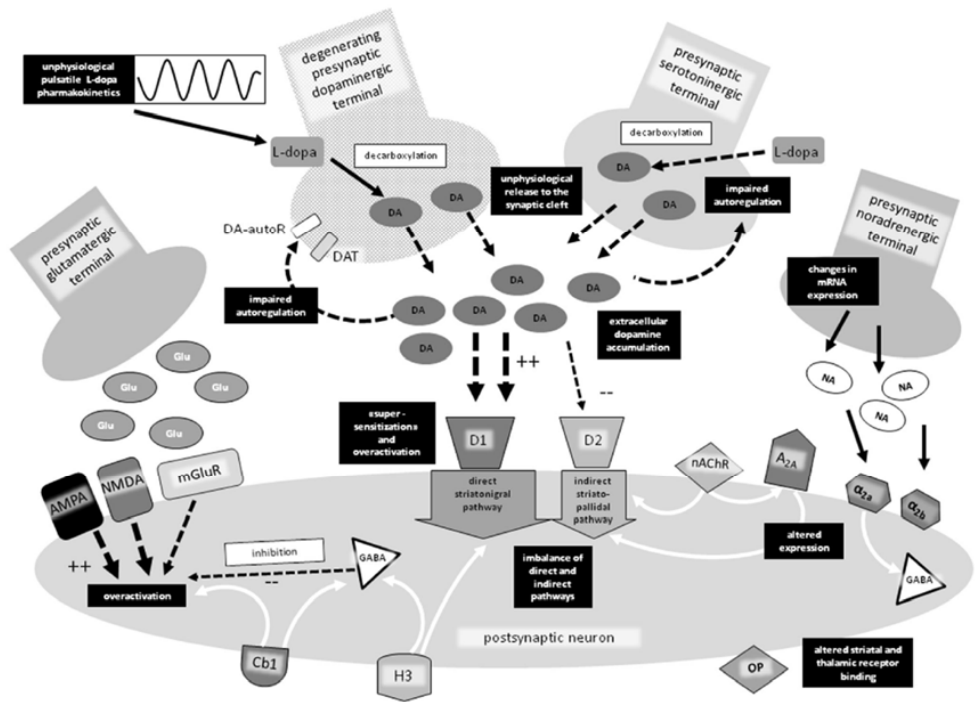
Figure 19. Pathophysiology of levodopa ‐ induced dyskinesia (Reprinted with permission from Springer Nature: Springer CNS Drugs Pharmacological Strategies for the Management of Levodopa ‐ Induced Dyskinesia in Patients with Parkinson’s Disease, Schaeffer, E.; Pilotto, A.; Berg, D., 2014 , doi: 10.1007/s40263 ‐ 014 ‐ 0205 ‐ z.[360]). Physiological activation, pathological alterations in LD ‐ induced dyskinesia (LID), pathological alterations in LID, modulation, ++ increased activation, ‐‐ decreased activation. A 2A adenosine receptor, α 2a and α 2ab noradrenergic receptors, AMPA α‐ amino ‐ 3 ‐ hydroxy ‐ 5 ‐ methyl ‐ 4 ‐ isoxazolepropionic acid, Cb 1 cannabinoid receptor, D 1 and D 2 dopaminergic receptors, DA dopamine, DA ‐ autoR dopamine autoreceptor, DAT dopamine transporter, GABA γ‐ aminobutyric acid, Glu glutamate, H 3 histamine receptor, LID levodopa ‐ induced dyskinesia, mGluR metabotropic glutamate receptor, NA noradrenaline, nAchR nicotinic acetylcholine receptors, NMDA N ‐ methyl ‐ D ‐ aspartate, OP opioid receptor.